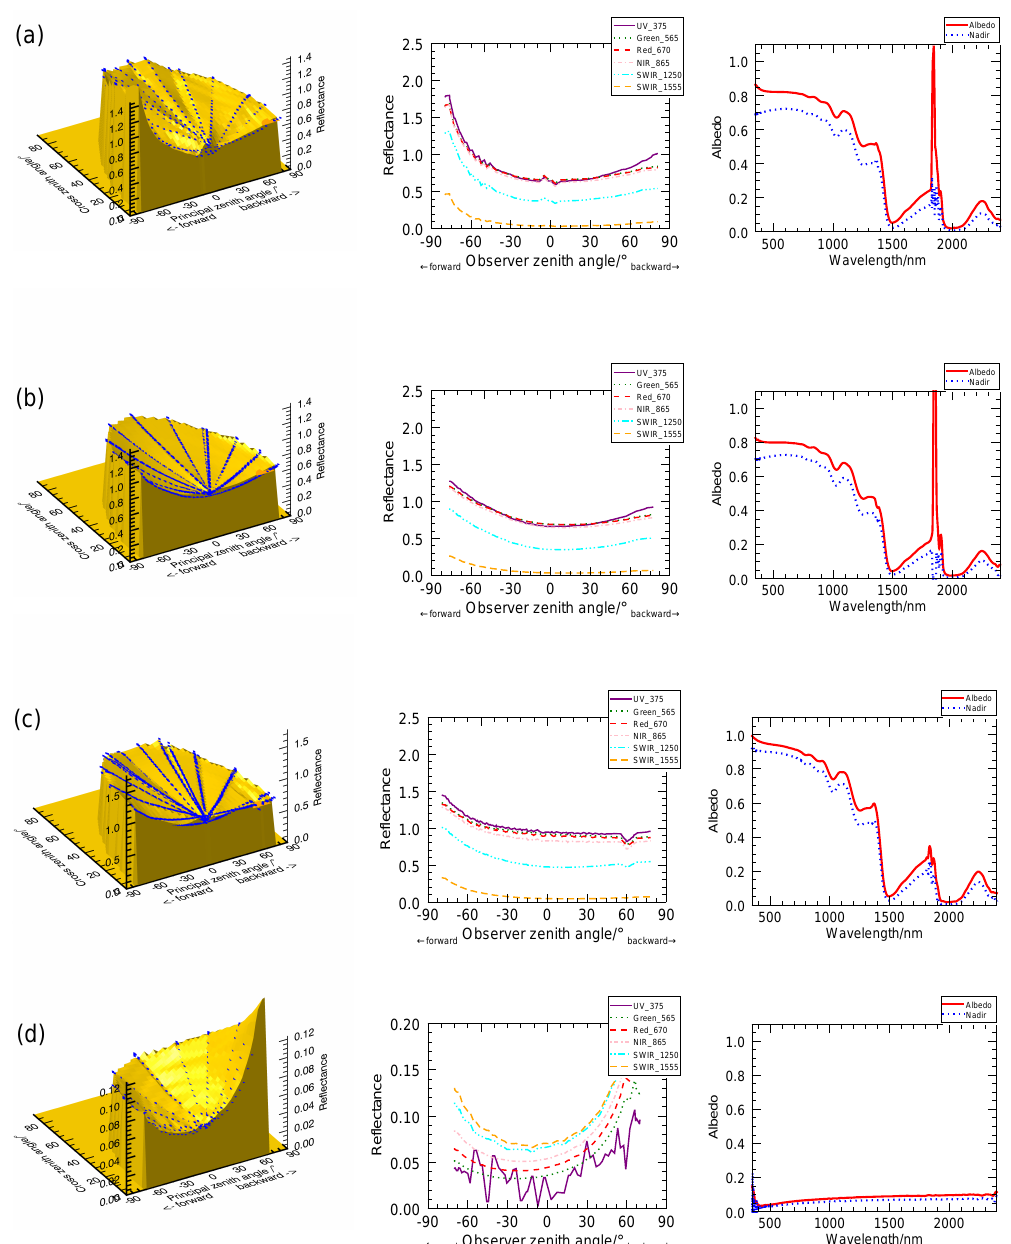
Figure 10. As in Fig. 9. Sooted snow on the 4 April 2013. Panel (a) shows the measurement which started at 09:56 with 68 ◦ solar zenith angle; (b) 10:31, 62 ◦ ; (c) 11:18, 63 ◦ ; and (d) the natural snow sample at 13:31, 62 ◦